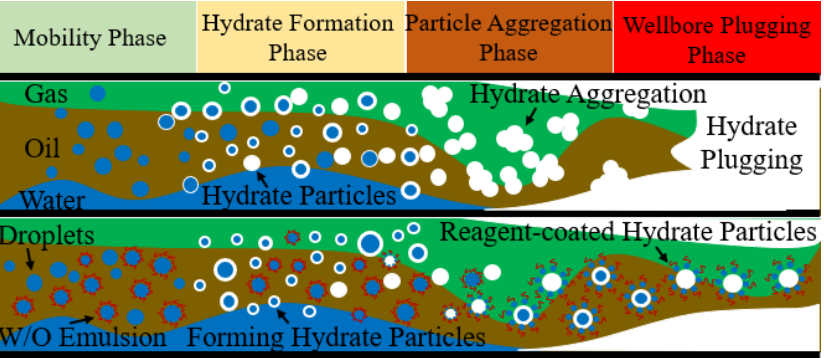
Figure 9. Schematic diagram of inhibition of hydrate particle aggregation by Span series surfactants (without and with Span surfactants, respectively).